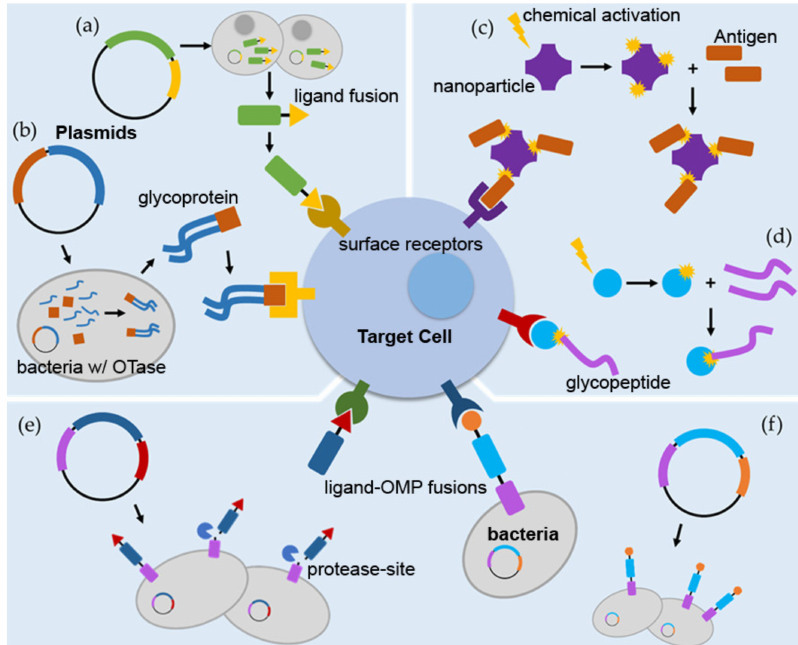
Figure 1. Schematic of targeted conjugate vaccines. ( a ) A plasmid encoding a protein subunit conju- gate is transfected into mammalian cells which secrete the fusion protein for subsequent purification and administration as a vaccine. Modeled after HA targeting to Xcr1 on DCs [44]. ( b ) A plasmid encoding a peptide carrier and capsular PS synthases is transformed into an oligosachride